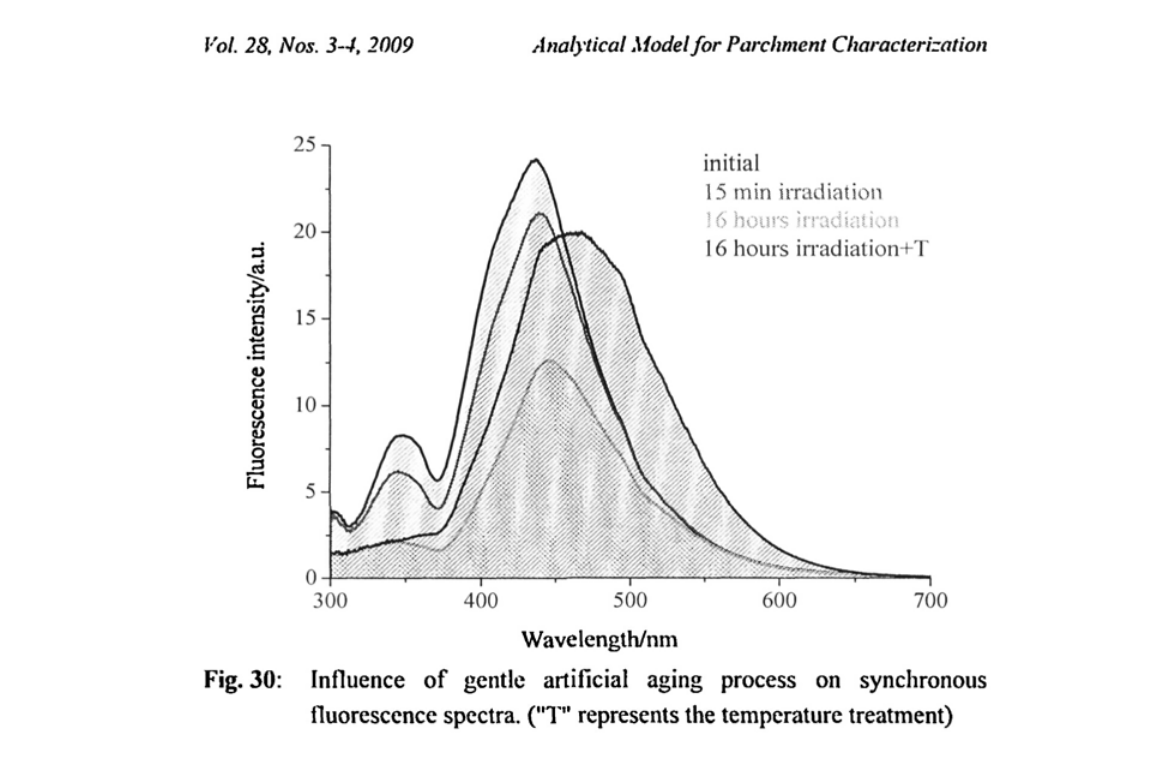
Fig. 30: Influence of gentle artificial aging process on synchronous fluorescence spectra. ("T" represents the temperature treatment) The best way to highlight the changes occurring in parchment samples during the gentle artificial aging process is by using the normalized fluorescence intensity. The normalized fluorescence intensity was calculated as an intensity ratio of each specific measurement to the fluorescence intensity of the initial sample through all the spectral range. Using this procedure, formation of two new peaks was observed when comparing the initial and the final parchment sample spectra. The first new peak was found at 312 nm, and the position of the second one was treatment dependent. In the case of the temperature treatment alone it was found at 590 nm and in the case of the full gentle artificial aging cycle at 564 nm (Figure